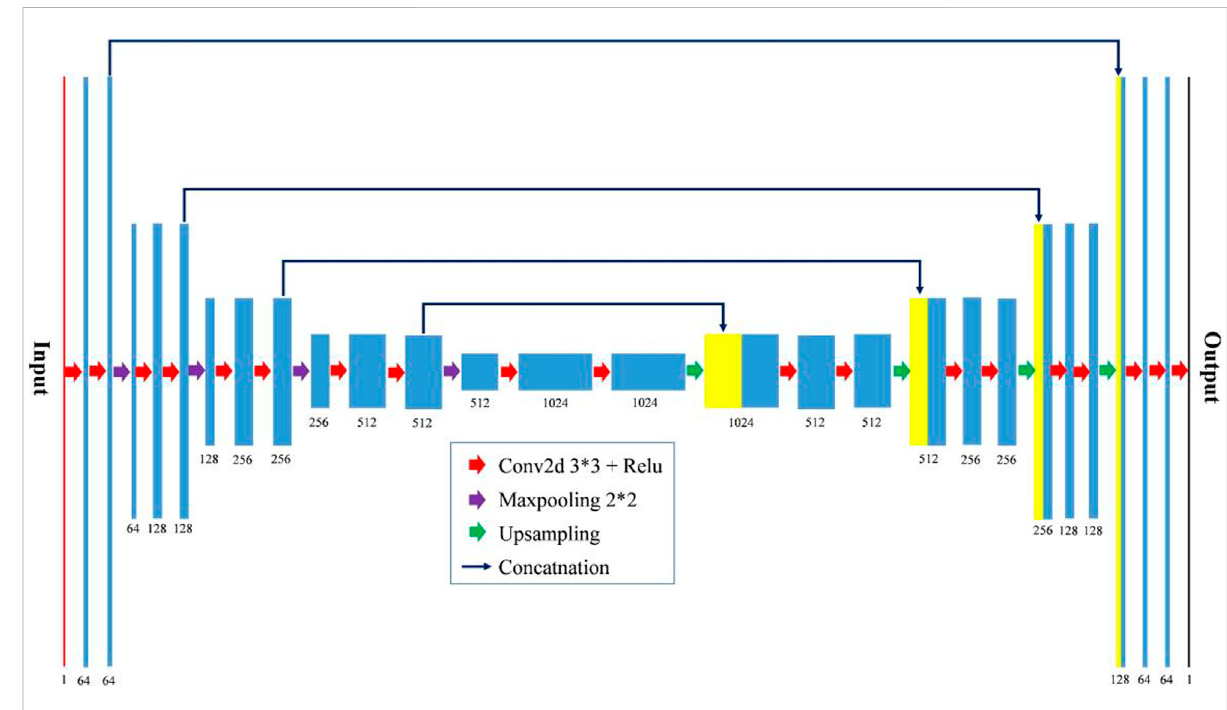
FIGURE 5 The proposed symmetrical convolutional neural network (U-Net) for automatic karst cave